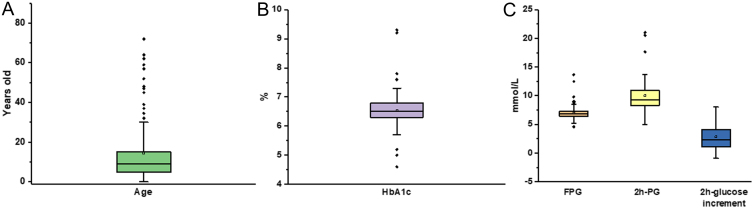
Whisker plot for continuous clinical data of Asian MODY2 patients. (A, B, and C) Continuous data for the variables of (A) age, (B) HbA1c, (C) FPG, 2h-PG, and 2h-glucose increment.